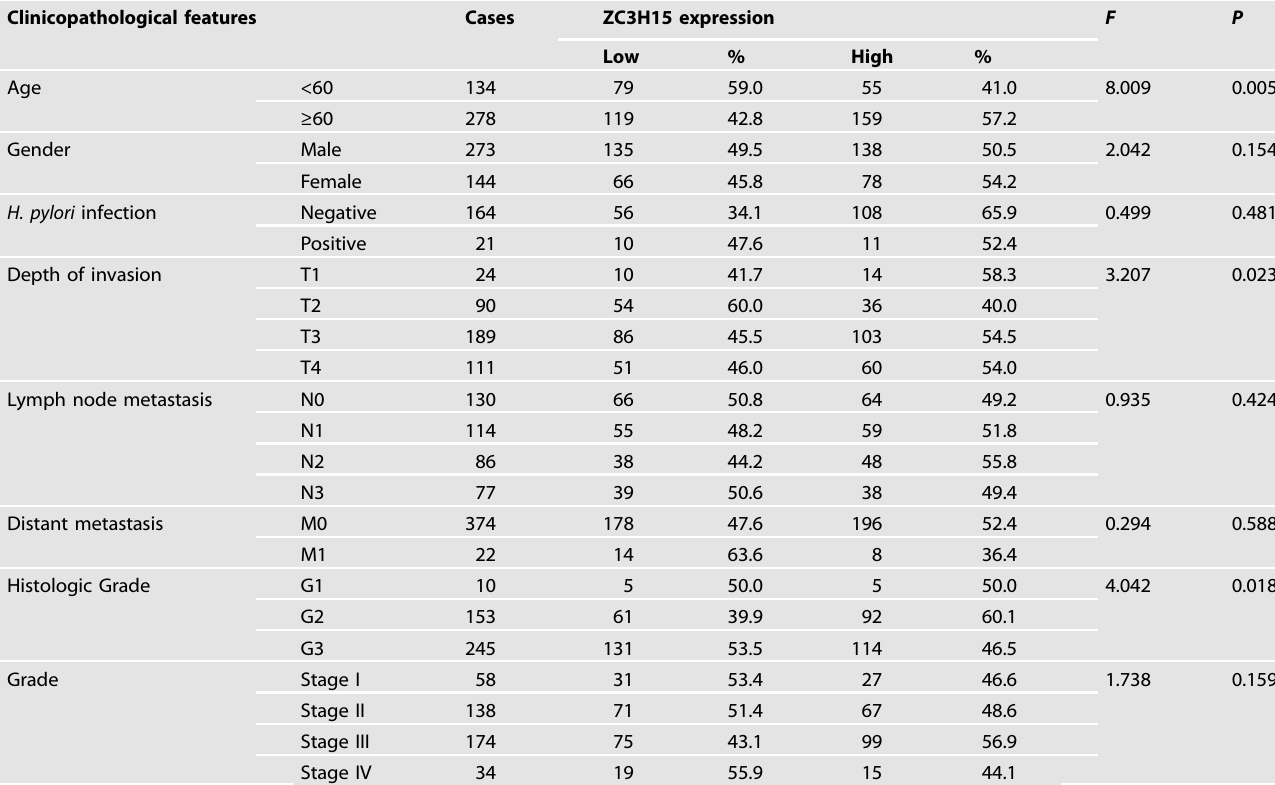
Table 2. Correlation of ZC3H15 expression with clinicopathological variables in TGGA datasets. Clinicopathological